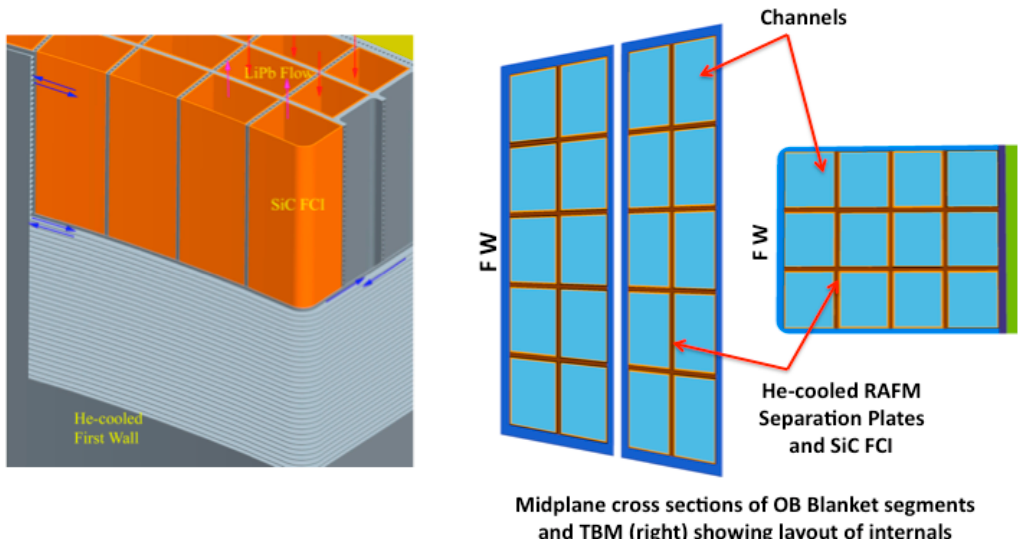
Figure 5. Isometric and midplane cross sections of the Dual ‐ Cooled PbLi (DCLL) blanket and Test Blanket Module (TBM) (not to scale).